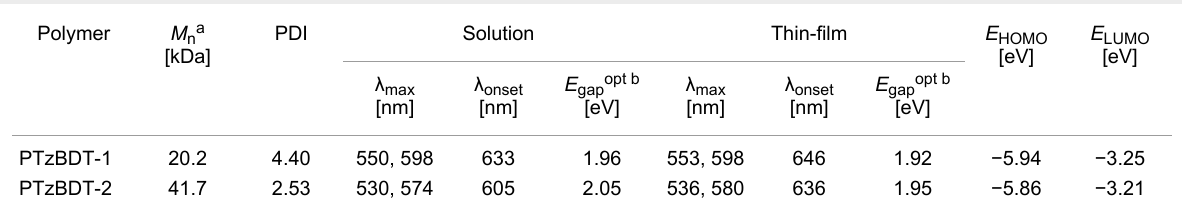
Table 1: Summary of the optical and electrochemical properties of PTzBDT-1 and